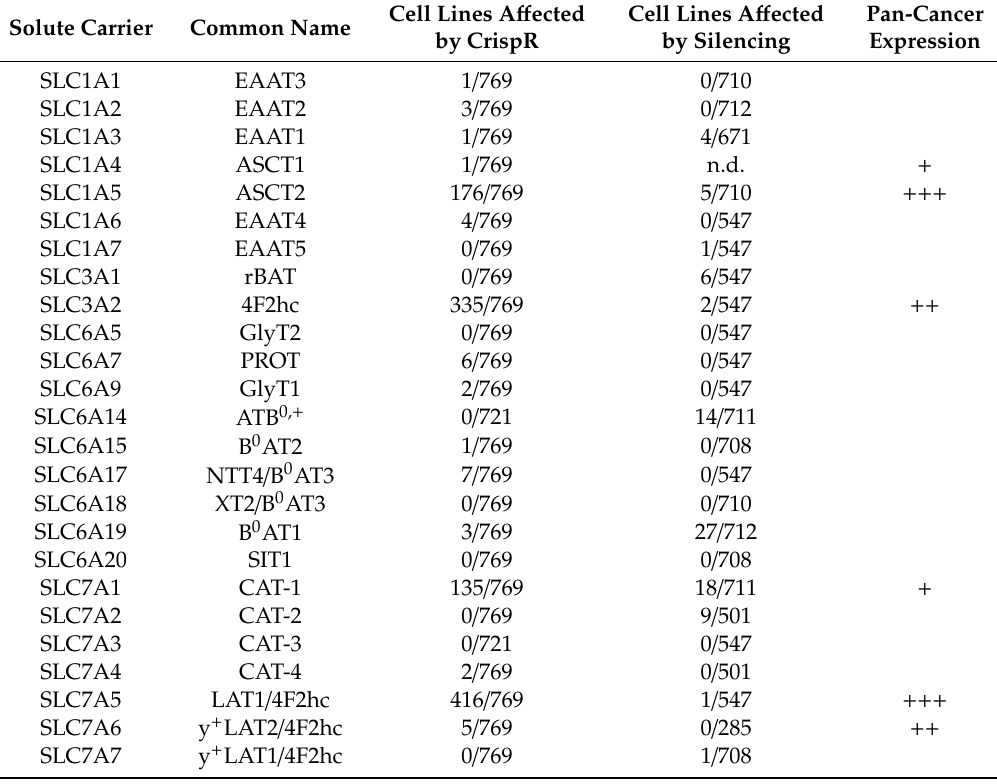
Table 2. Transporters as cancer therapeutic targets. Silencing and CrispR ko data from https: // Depmap.org are shown. Transporters are listed by solute carrier number and common name. Four widely used nontransporter targets are listed for comparison at the end of the table. Transporters that are expressed consistently across all cell lines are shown as ( + ) for low expression levels, ( ++ ) for elevated expression levels, ( +++ ) for high expression levels. N.d. not